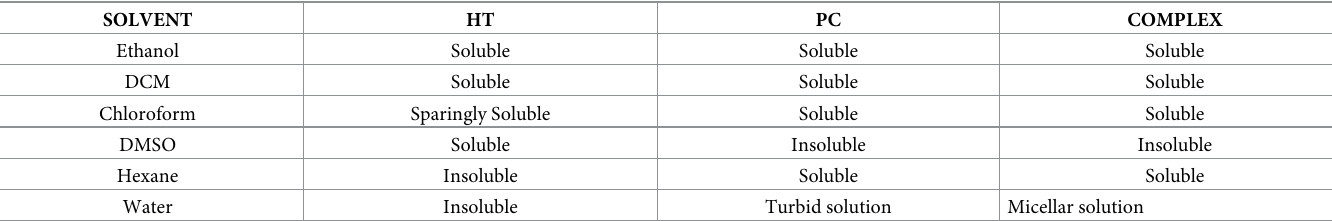
Table 5. Solubility studies of HT, PC, and HTN. SOLVENT HT PC COMPLEX Ethanol Soluble Soluble Soluble DCM Soluble Soluble Soluble Chloroform Sparingly Soluble Soluble Soluble DMSO Soluble Insoluble Insoluble Hexane Insoluble Soluble Soluble Insoluble Turbid solution Micellar